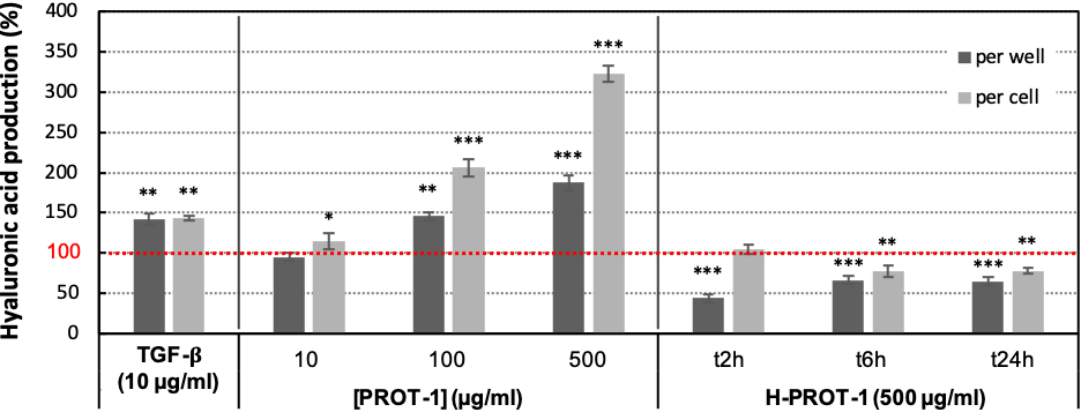
Figure 9. Hyaluronic acid production per well and per cell by the human dermal fibroblast cell line 1059. Results are expressed as the mean relative percentage of production, compared to the negative control (100%). Significant differences between values obtained with samples and negative control ( n = 9) by * ( p < 0.05), ** ( p < 0.01) and *** ( p < 0.001).